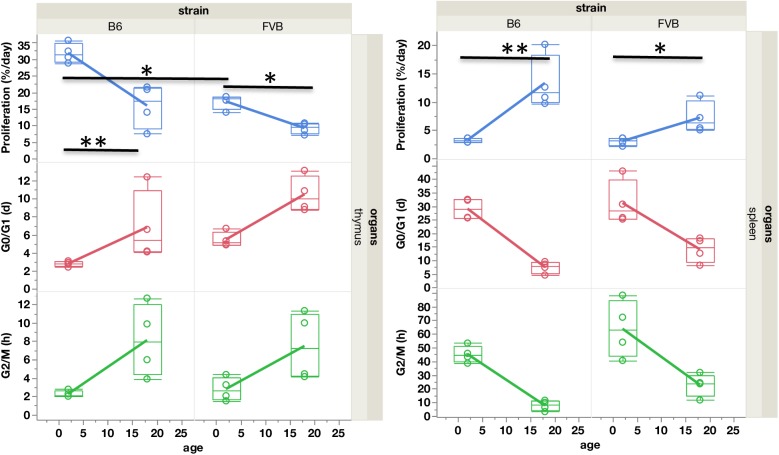
Proliferation rates and cell cycle phase durations in thymus and spleen.Proliferation rates (%/day), G0/G1 and G2/M phase durations (in days) in B6 and FVB mice (n = 4 per group) according to age (2 and 18 months) in whole thymus (left) and whole spleen (right). Values are indicated in the box plot, the median is the 50th percentile, the lower and upper limits of the box are the 25th and 75th percentiles and the whiskers indicate 1.5x(interquartile range). *: p<0.05. **: p<0.01. (See Materials and Methods section for statistical tests used). Statistics are for proliferation rates only. Mean values and SD are given in S1 Table.